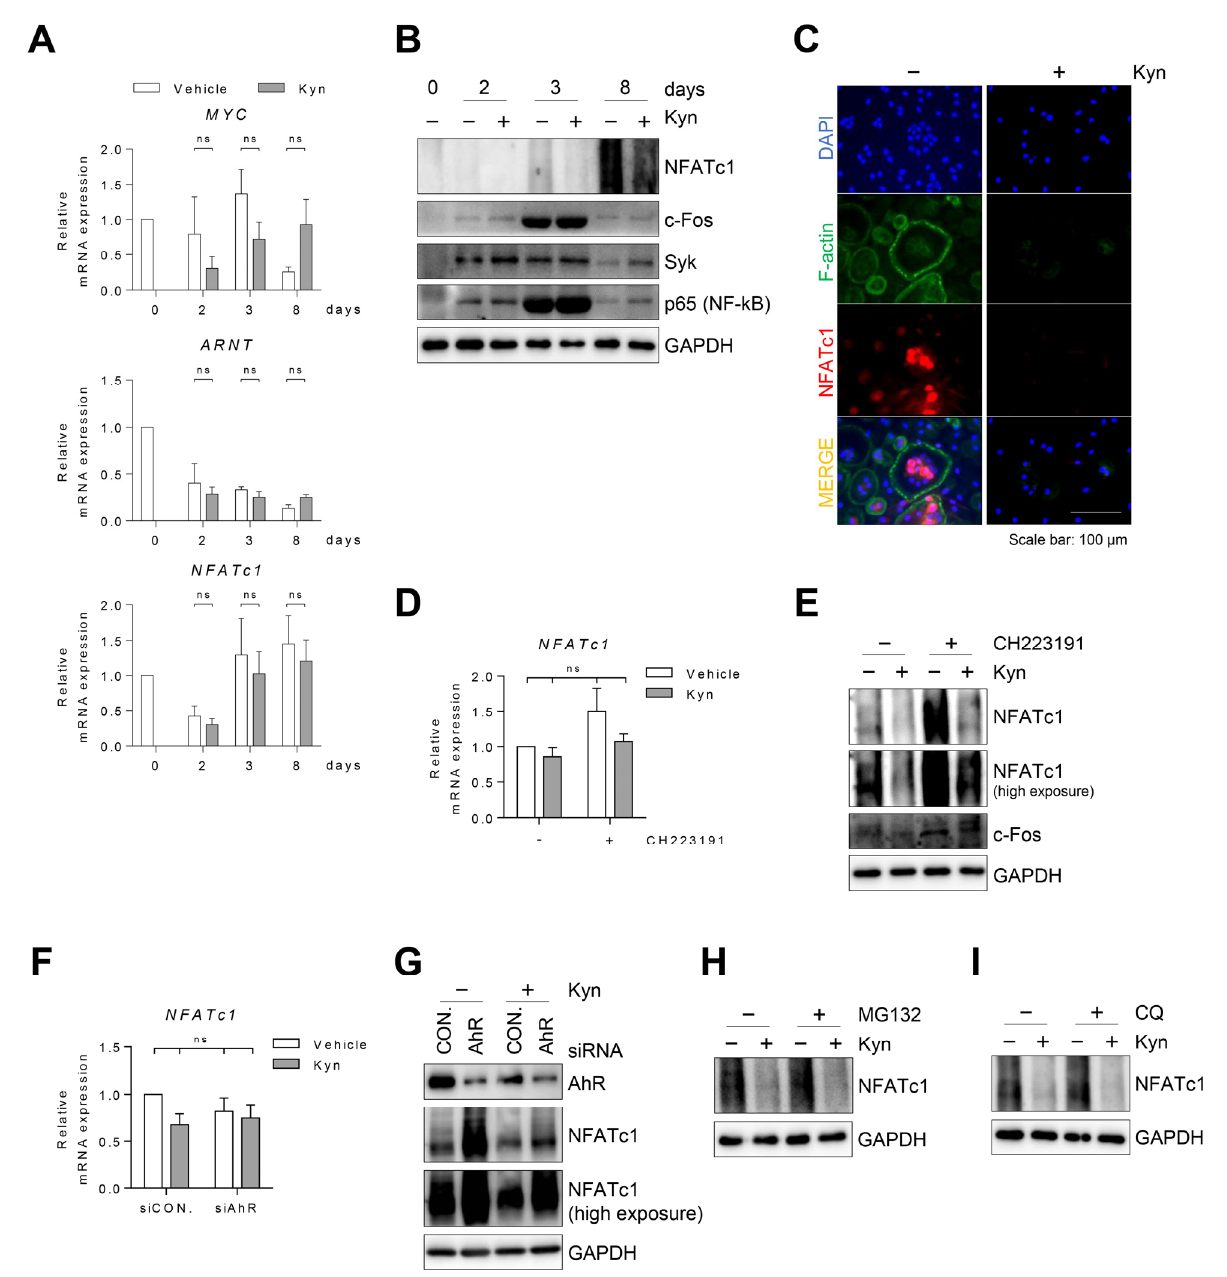
Figure 6. Kyn reduces NFATc1 protein in osteoclasts. Human PBMC CD14+ cells were cultured with Kyn (100 µ M) under osteoclast differentiation conditions. ( A ) The mRNA expression of Myc , ARNT , and NFATc1 was measured using RT-qPCR and then normalized to that of GAPDH . ( B ) Level of NFATc1, c-Fos, Syk, and p65 proteins was detected by immunoblotting. ( C ) Immunostaining with NFATc1 (red), F-actin (green), and DAPI (blue) were observed. Scale bar is 100 µ m. ( D , E ) Human PBMC CD14+ cells were pretreated with CH223191 (5 µ M) for 3 h and then cultured with Kyn (100 µ M) under osteoclast differentiation conditions. On day 8, ( D ) mRNA expression and ( E ) protein level of NFATc1 were analyzed by RT-qPCR and immunoblotting. ( F , G ) After transfection, ( F ) mRNA expression and ( G ) protein level of NFATc1 were analyzed by RT-qPCR and immunoblotting on day 7. ( H , I ) Human PBMC CD14+ cells were cultured with Kyn (100 µ M) under osteoclast differentiation conditions. On day 8, MG132 (10 µ M) or CQ (50 µ M) was added in the osteoclasts for 6 h. Level of NFATc1 protein was detected by immunoblotting. Data are shown as mean ± SD of more than three independent experiments and a two-way ANOVA test was applied. ns p > 0.05.